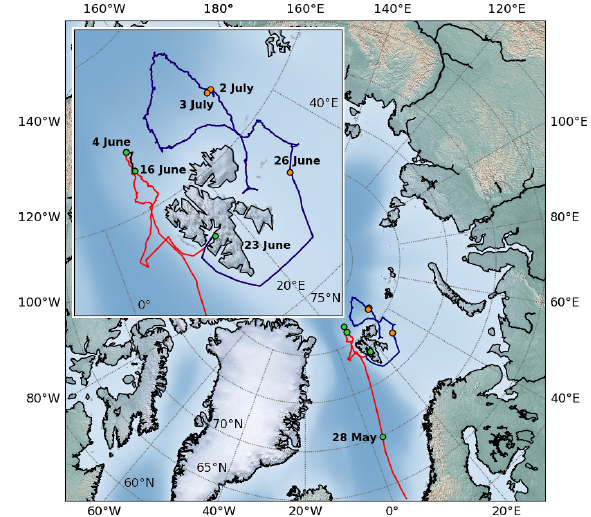
Figure 1. Cruise track of the Polarstern PS106 expedition is shown on a polar stereographic map of the Arctic. The red line shows the track for the first leg (PS106/1, also denoted as PASCAL), the black line indicates the position for the ice floe camp during PASCAL, and the blue line shows the cruise track for the second leg (PS106/2, also denoted as SiPCA). The upper left box zooms in the ice floe camp drift. Green dots indicate the start of the PASCAL and SiPCA legs, and the beginning and end of the ice floe camp. Orange dots depict the location of several case